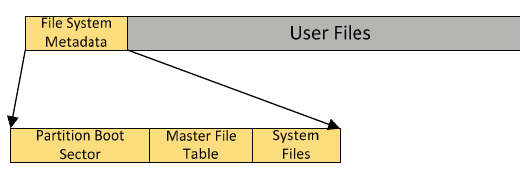
Figure 5. The layout of the NTFS